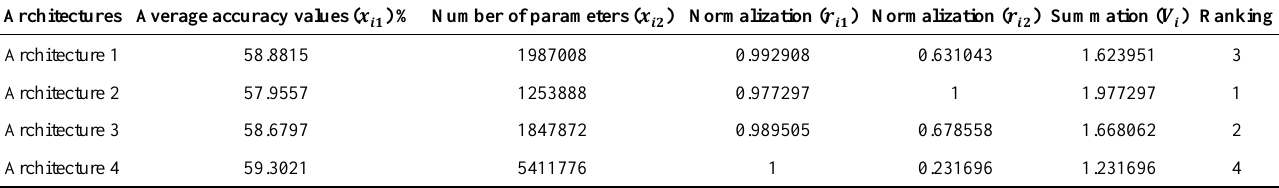
Table 2. Normalization results for the first stage of the DEAP dataset